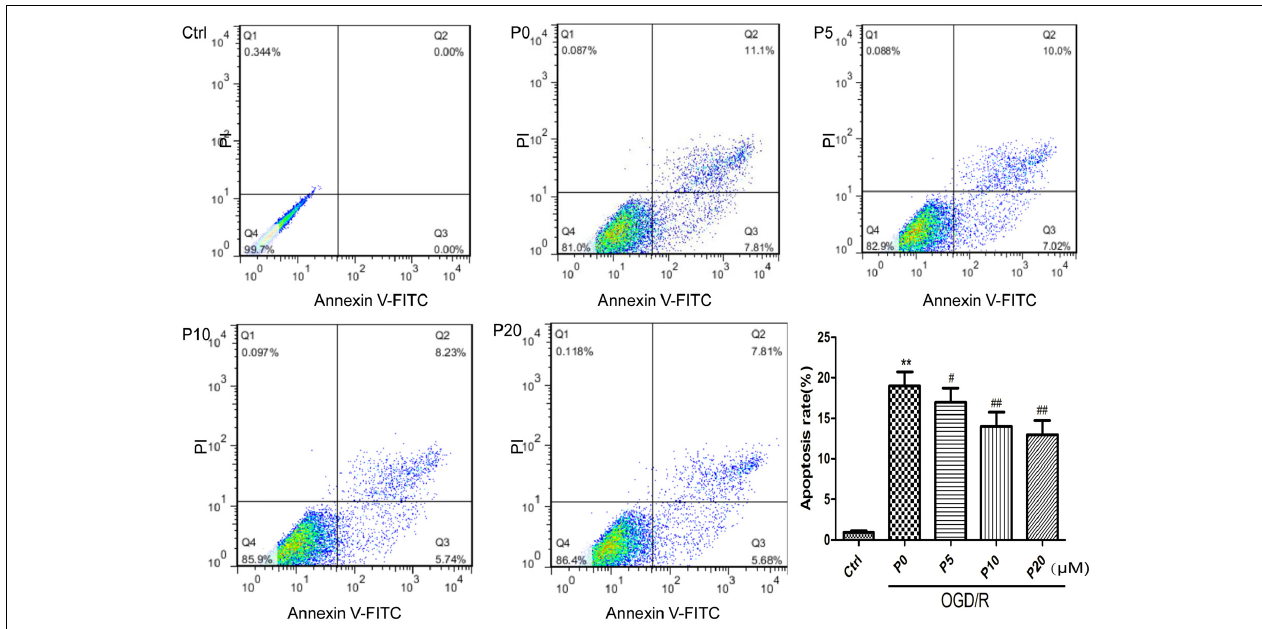
FIGURE 2 | Propofol significantly inhibited H9c2 cells apoptosis induced by OGD/R injury. The cells were analyzed by flow cytometry. The data are presented as the mean ± SD of at least three independent experiments. ∗∗ P < 0.01 versus control, # P < 0.05, ## P < 0.01 versus OGD/R group without